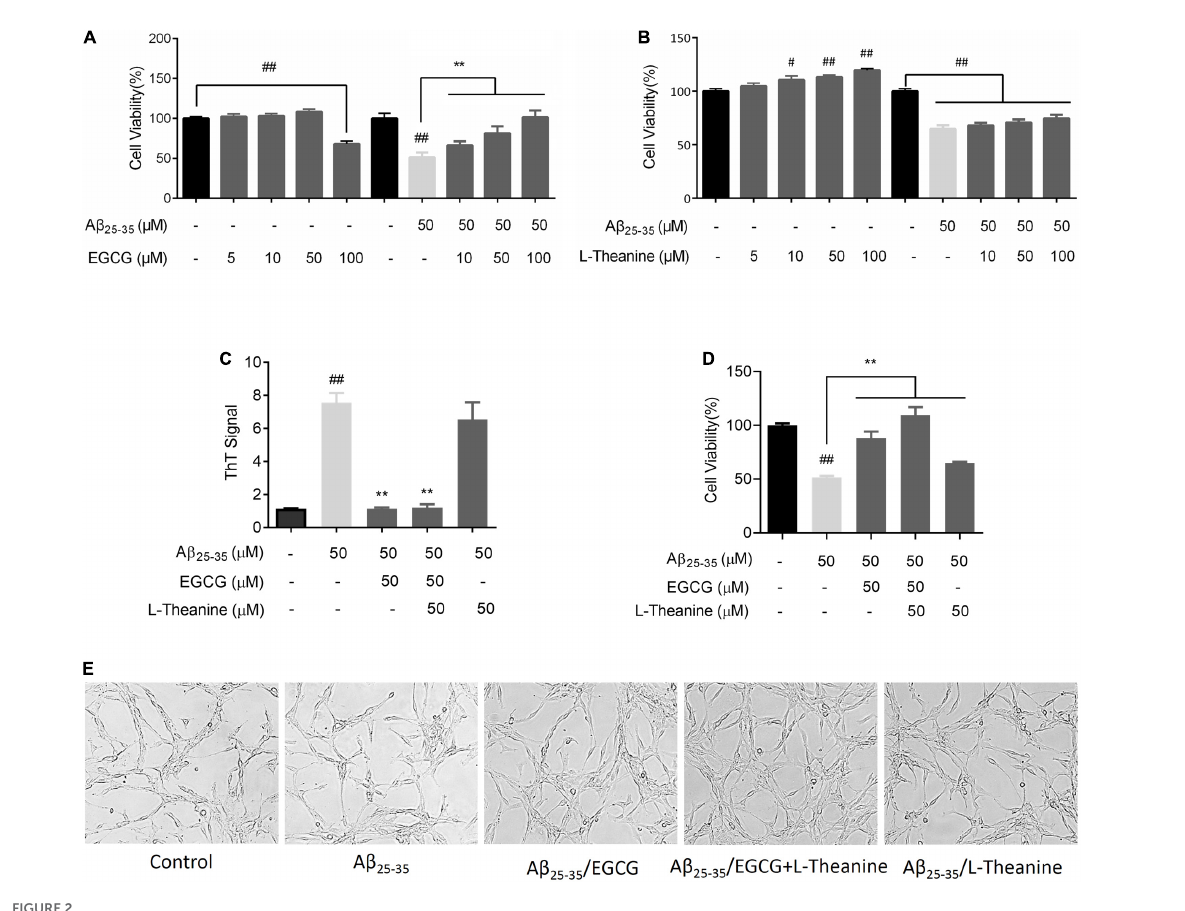
FIGURE2 EGCG and L -theanine synergistically protect PC12 cells from Abeta 25 − 35 -induced injury. (A) MTT assay of cell viability in EGCG or A β 25 − 35 /EGCG treated group. (B) MTT detection of cells viability in L -theanine or A β 25 − 35 / L -theanine treated group. (C) ThT assay of different A β 25 − 35 proteins samples. (D) MTT assay of cell viability in the synergistic group of EGCG and L -theanine. (E) White light photography of cell morphology. # p < 0.05, ## p < 0.01, compared with control group; ** p < 0.01, compared with A β 25 − 35 group, n =